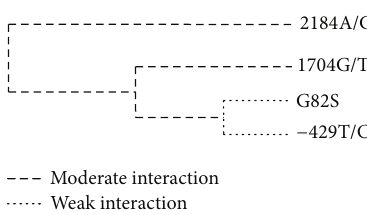
Figure 1: Interaction dendrogram for the best 4-locus SNP model selected by the MDR. The dashed line indicates moderate interac- tion, and the dotted line indicates